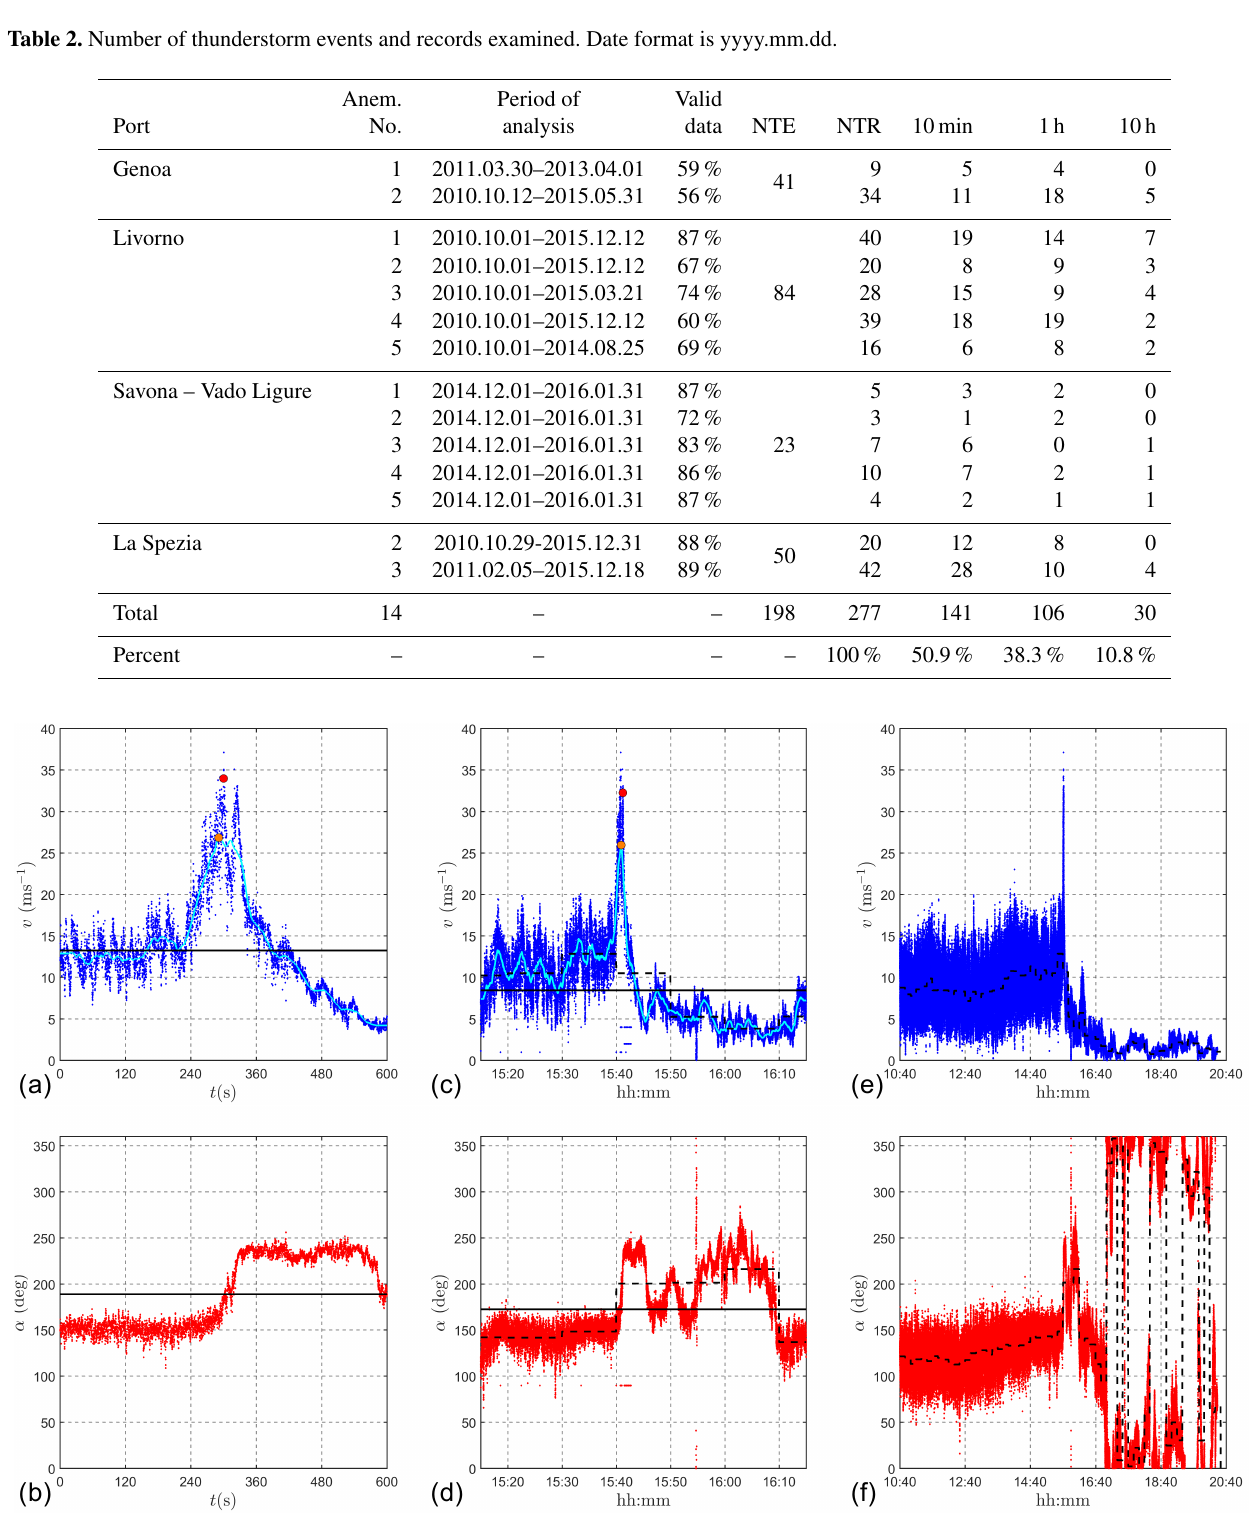
Figure 8. Thunderstorm outflow recorded on 25 October 2011 at about 15:40UTC by the anemometer 3 of the port of La Spezia: wind speed time-series in 10min (a) , 1h (c) , and 10h (e) ; wind direction time-series in 10min (b) , 1h (d) , 10h (f)